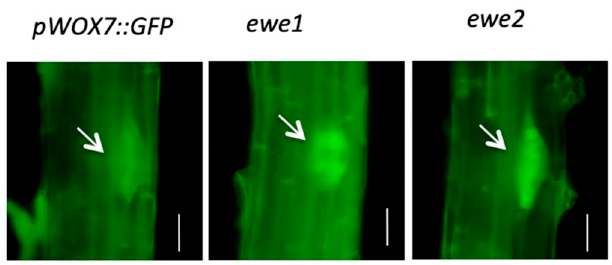
Figure 2. Two mutants with enhanced WOX7 expression in lateral root primordia (arrows) in 10-day-old seedlings, as shown by green fluorescence from the WOX7pro::GFP reporter gene. Bars = 50 µ m.